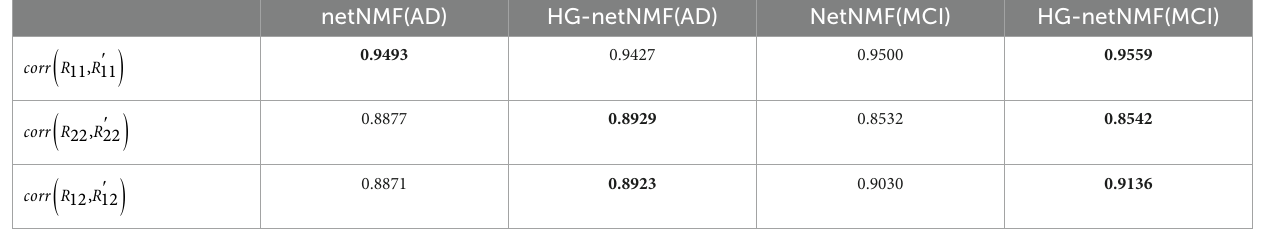
TABLE 4 Pearson correlation coefficients between the three original matrices and the three reconstructed matrices obtained by the two algorithms in the AD group and the MCI group.